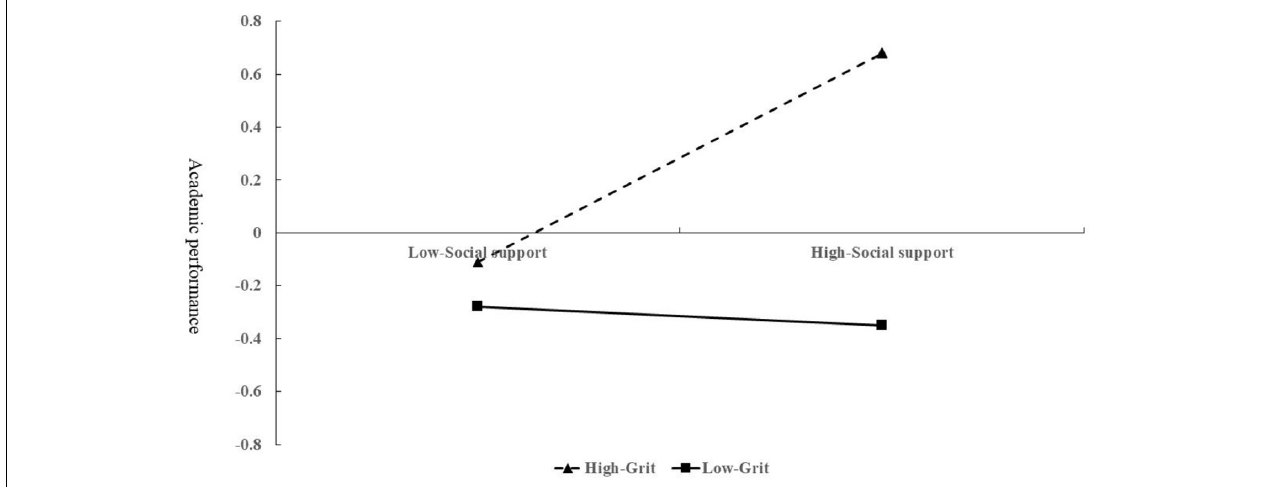
FIGURE 2 | Moderating effect of grit on the relationship between social support and academic